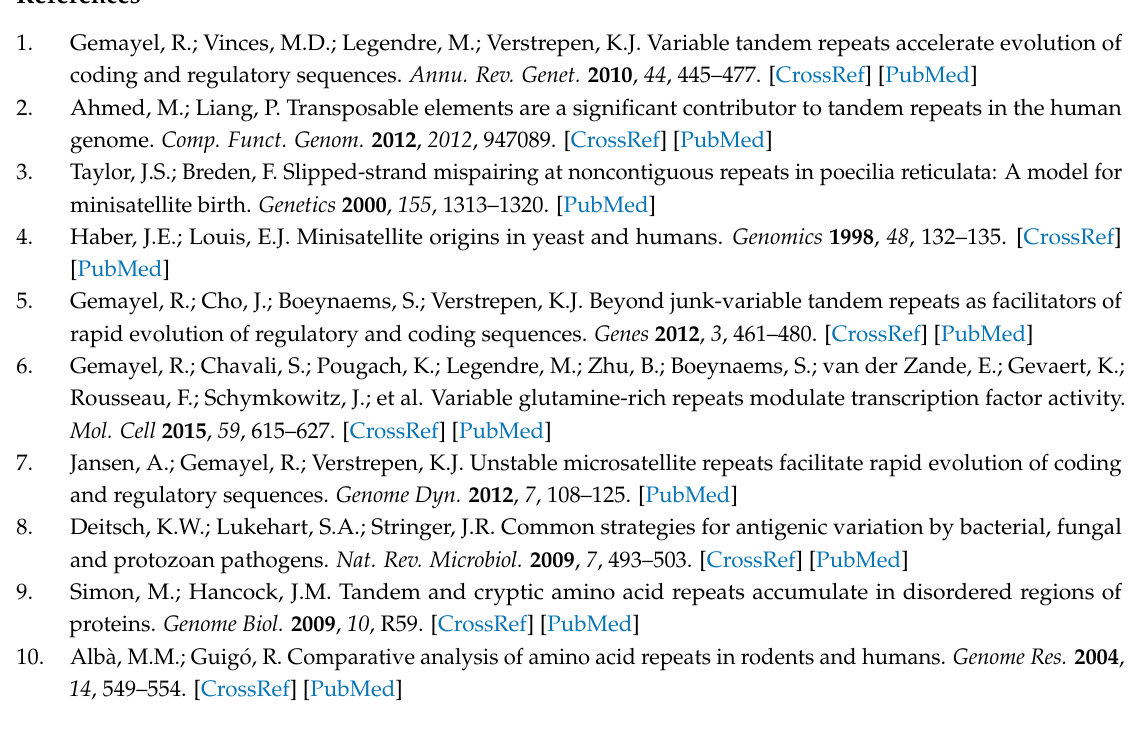
Table S1: Strains and Alleles, Table S2: Primers, Table S3: